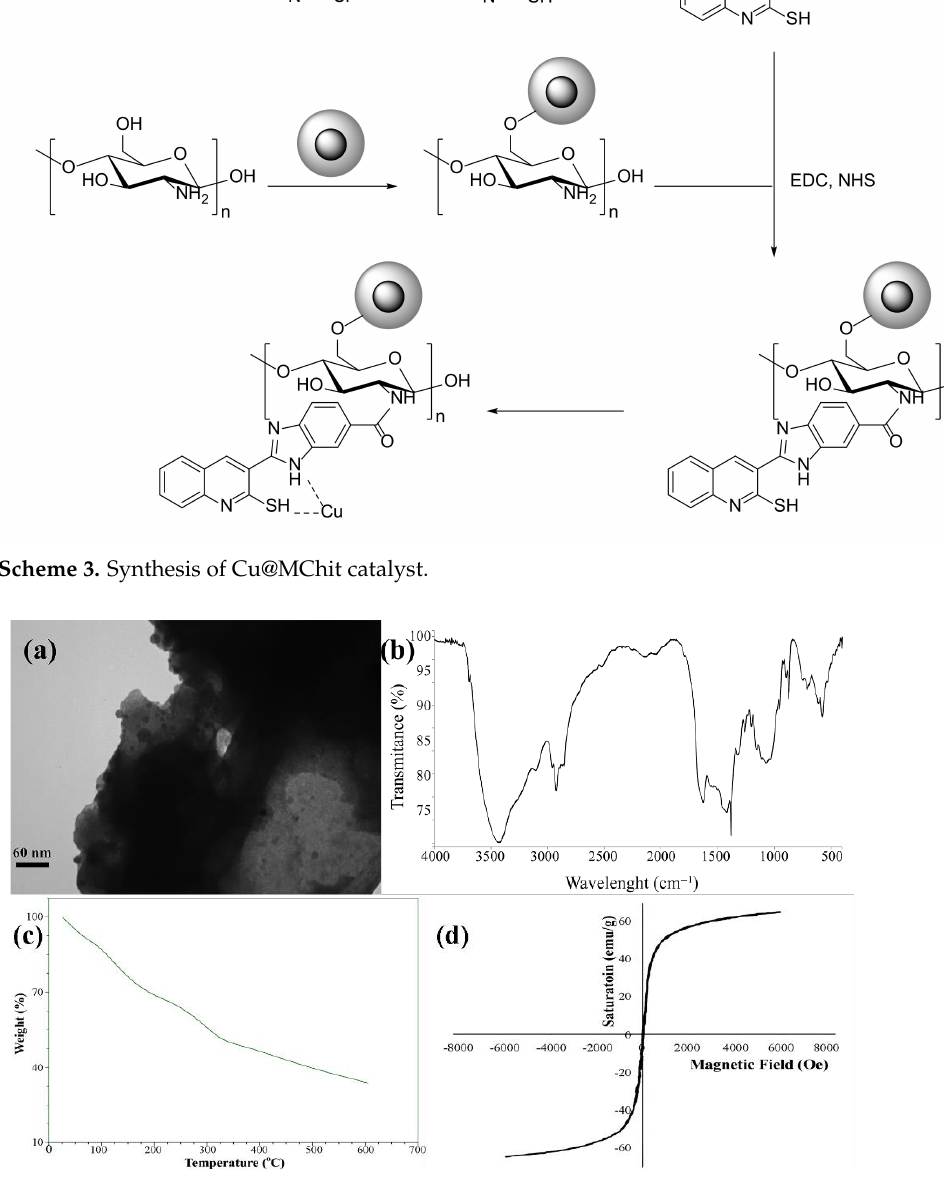
Figure 1. The characterization results of Cu@MChit catalyst. ( a ) TEM, ( b ) FTIR, ( c ) TGA, and ( d ) VSM results.